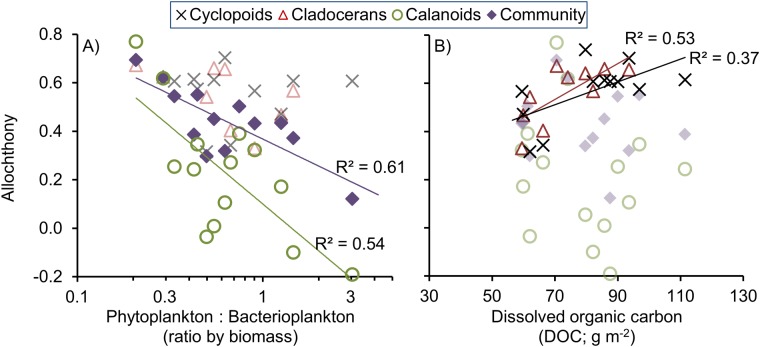
Allochthony in the different zooplankton groups as functions of (A) the ratio between phytoplanktonic and bacterioplanktonic biomassa and (B) amount dissolved organic carbon in lake Övre Björntjärn.Regression lines are drawn separately for each zooplankton group which represents significant (p < 0.05) correlations. Zooplankton groups without significant correlations are shown in faded (50% less ink) symbols. Note the logarithmic scale on the x axis in banner A. aExcluding one extreme low-end outlier on July 28, 2009, when the algal bloom was interrupted by a rain storm which suddenly flushed most of the phytoplankton biomass out of the lake (see Fig. 1a and S1 Table).